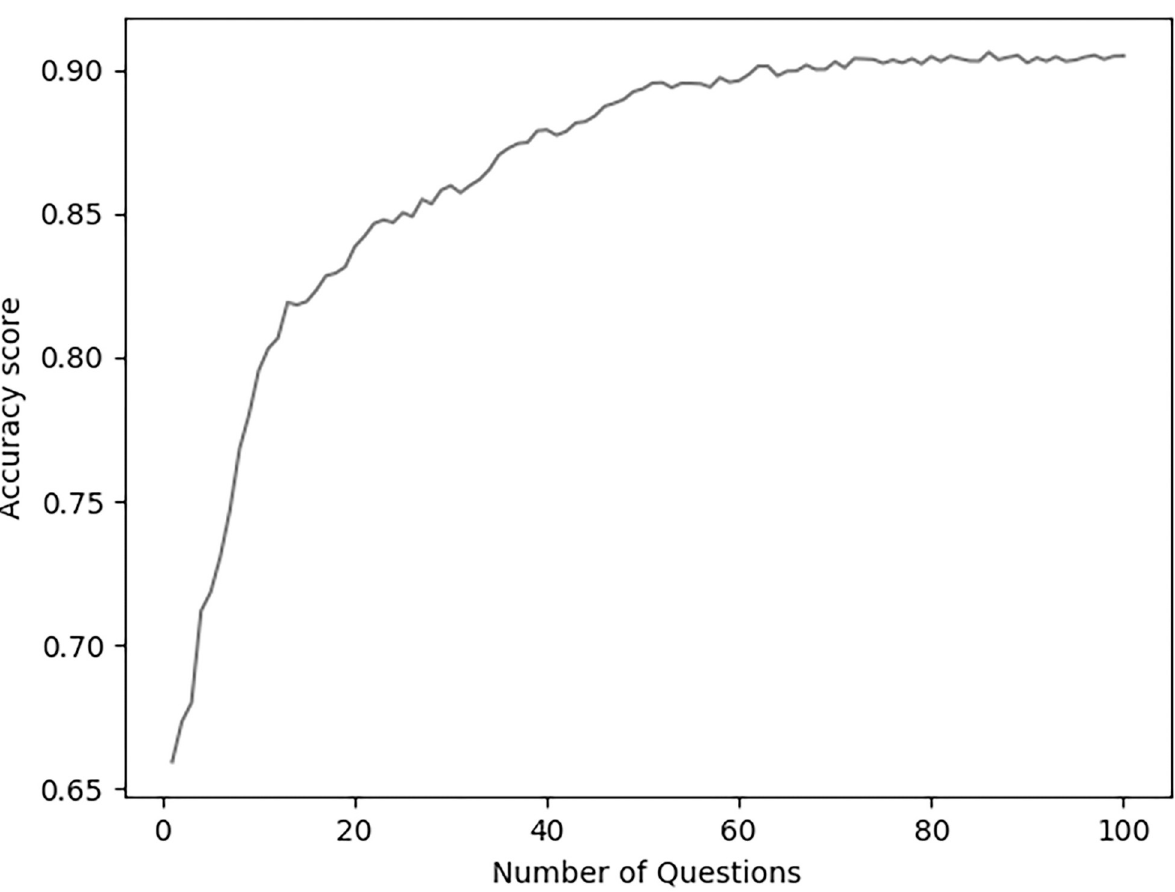
Fig 6. Accuracy scores using the Top-N questions in a cumulative fashion. Results for average model performance of the LightGBM model using the N top questions, along the X-axis. As the number of questions given to the model increases, so does the accuracy.